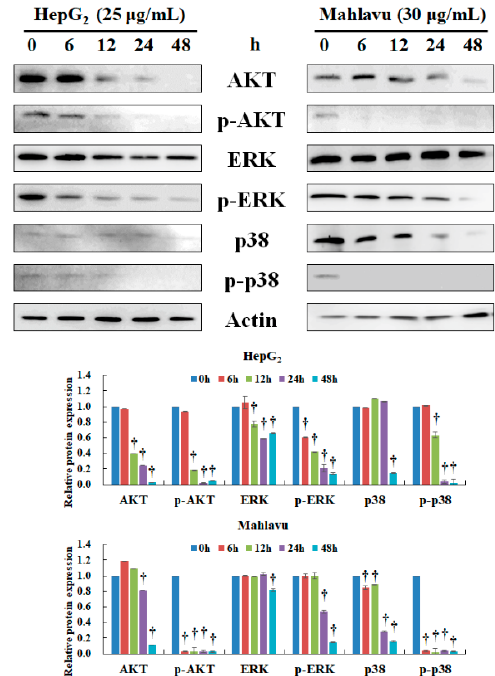
Figure 3. Effect of CAt extract treatment on AKT, ERK, and p38 protein expression in HepG 2 and Mahlavu cells. HepG 2 and Mahlavu cells were incubated with CAt extract (25 or 30 µ g / mL) for the indicated time points (0, 6, 12, 24, and 48 h) then subjected to Western blotting analysis. The actin level was used as loading control. *, †: Signi fi cant di ff erence between control and treatment, p < 0.05.